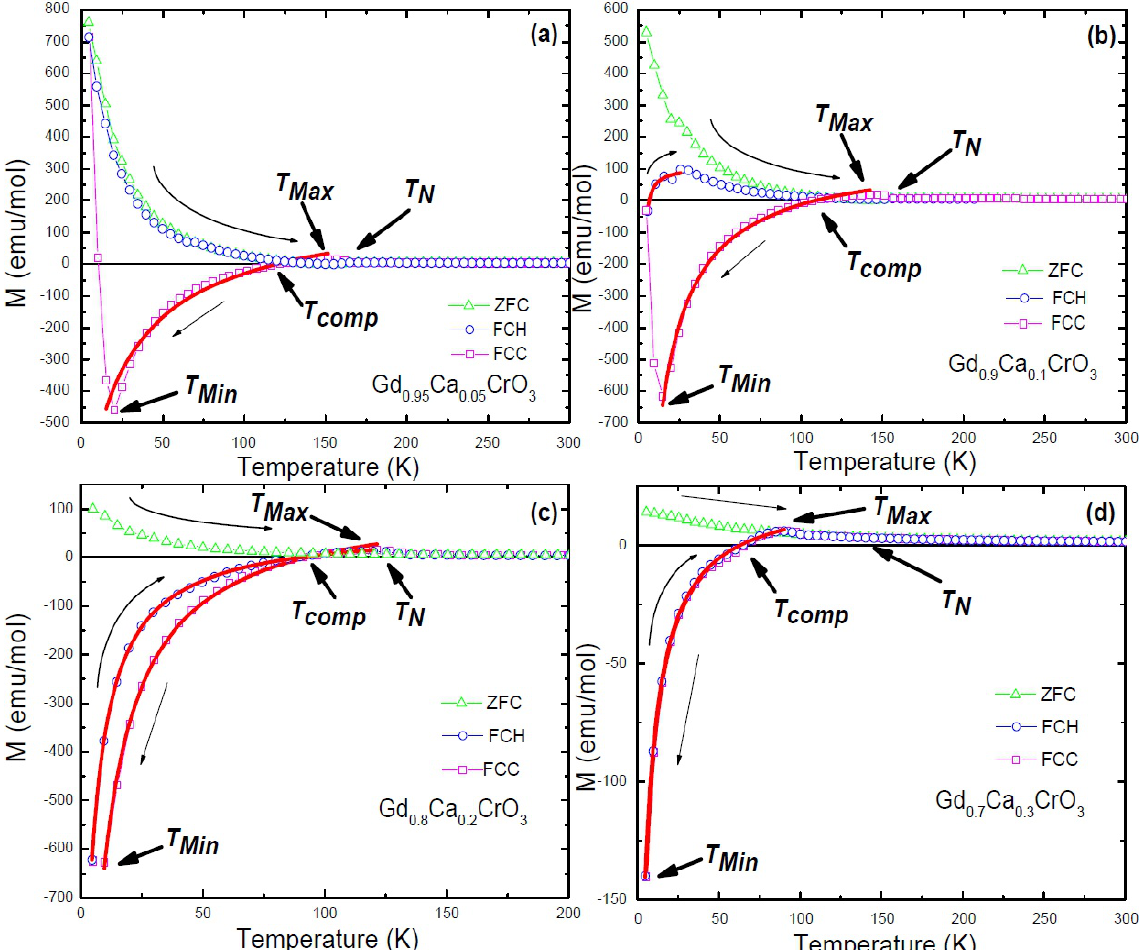
Fig. 6. DC temperature dependent magnetization curve in ZFC, FCC, FCH mode for (a) Gd Gd Ca CrO ,(c) Gd Ca CrO ,(d) Gd Ca CrO . Solid line shows fitting using Eq. (1) of M - T data 0.9 0.1 3 0.8 0.2 3 0.7 0.3 3